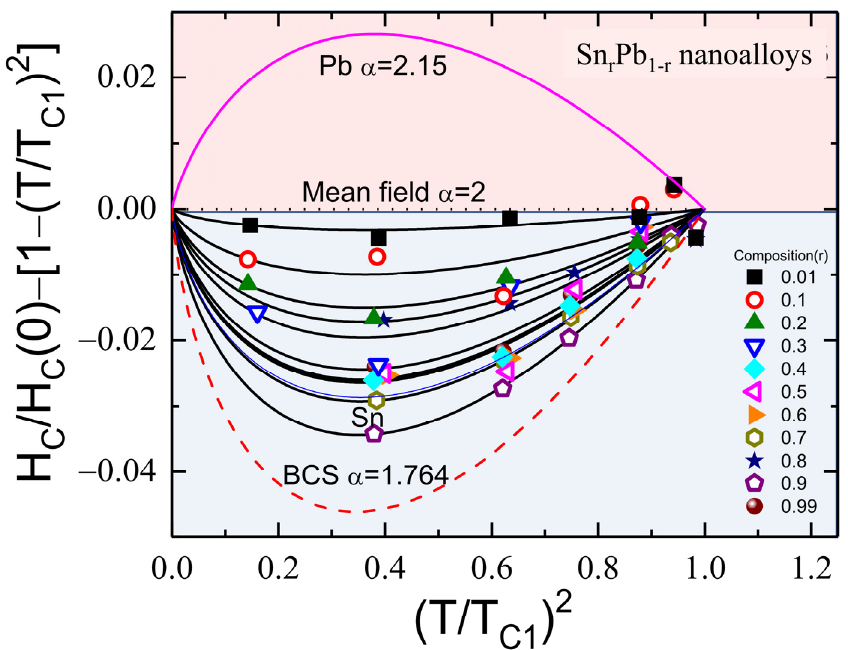
Figure 7. Deviation of H C (T)/H C (0) from the parabolic dependence of 1 − (T/T C1 ) 2 fitted to the expression H C (T)/H C (0) = [1 − (T/T C1 ) α ], where α represents the coupling strength of the supercon-